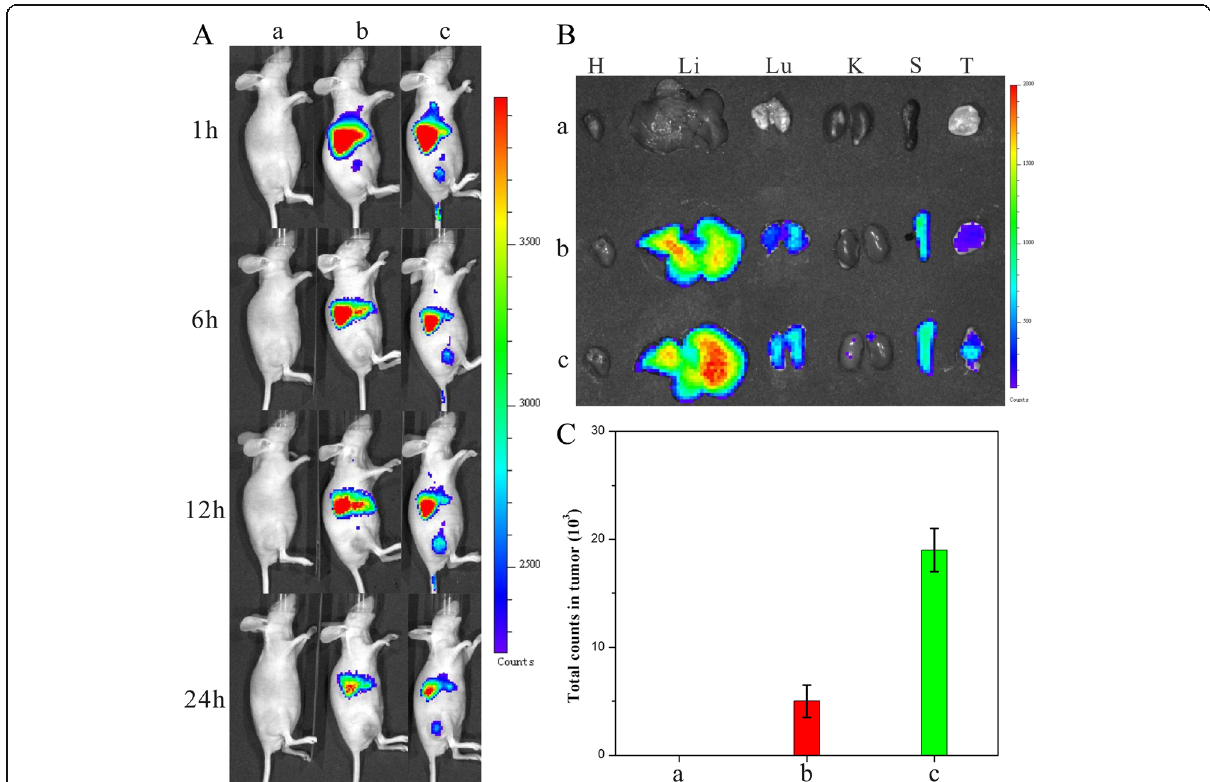
Fig. 11 a Distribution and tumor accumulation of DiR-nanoparticles in HeLa tumor-bearing mice receiving intravenous injection of the indicated formulations. b Ex vivo fluorescence imaging of the tumor and normal tissues harvested from the euthanized HeLa tumor-bearing nude mice. The images were taken 24 h after the injection. H, Li, Lu, K, S, and T represent the heart, liver, lung, kidney, spleen, and tumor, respectively. c DiR fluorescence intensity in tumor tissues collected at 24 h following systemic injection. P < 0.05. ( a ) 0.9% NaCl, ( b ) DiR-NDs, and ( c )